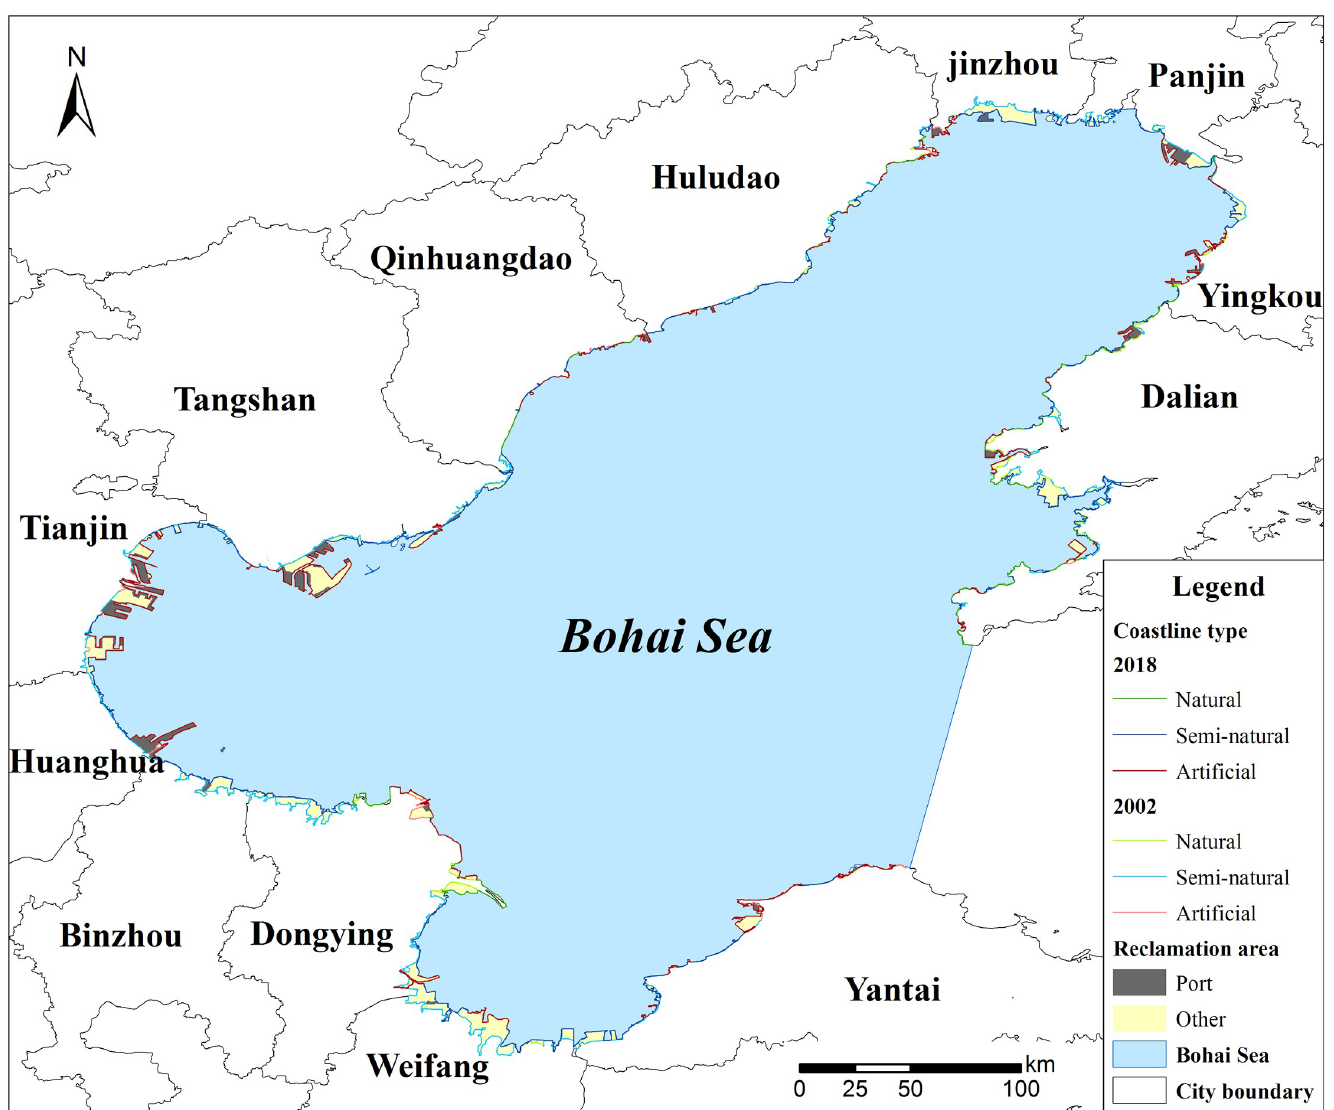
Fig 3. Changes of coastline length of natural, semi-natural, artificial types, reclamation area in the reclaimed area in 2002–2018 in the Bohai Sea. From the perspective of spatial distribution, the reclaimed areas in the main ports were more than 300 km 2 . The natural coastline length in Tianjin decreased sharply and artificial coastline length increased